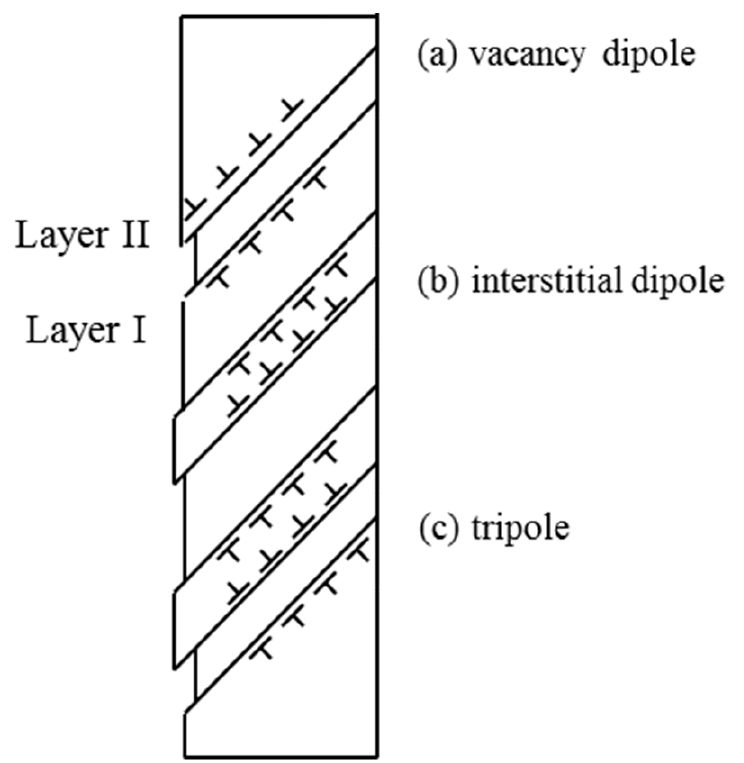
Figure 5. Dislocations in ( a ) vacancy dipoles (forming an intrusion), ( b ) interstitial dipoles (forming an extrusion) and ( c ) tripoles (forming an intrusion-extrusion pair) at the surface.